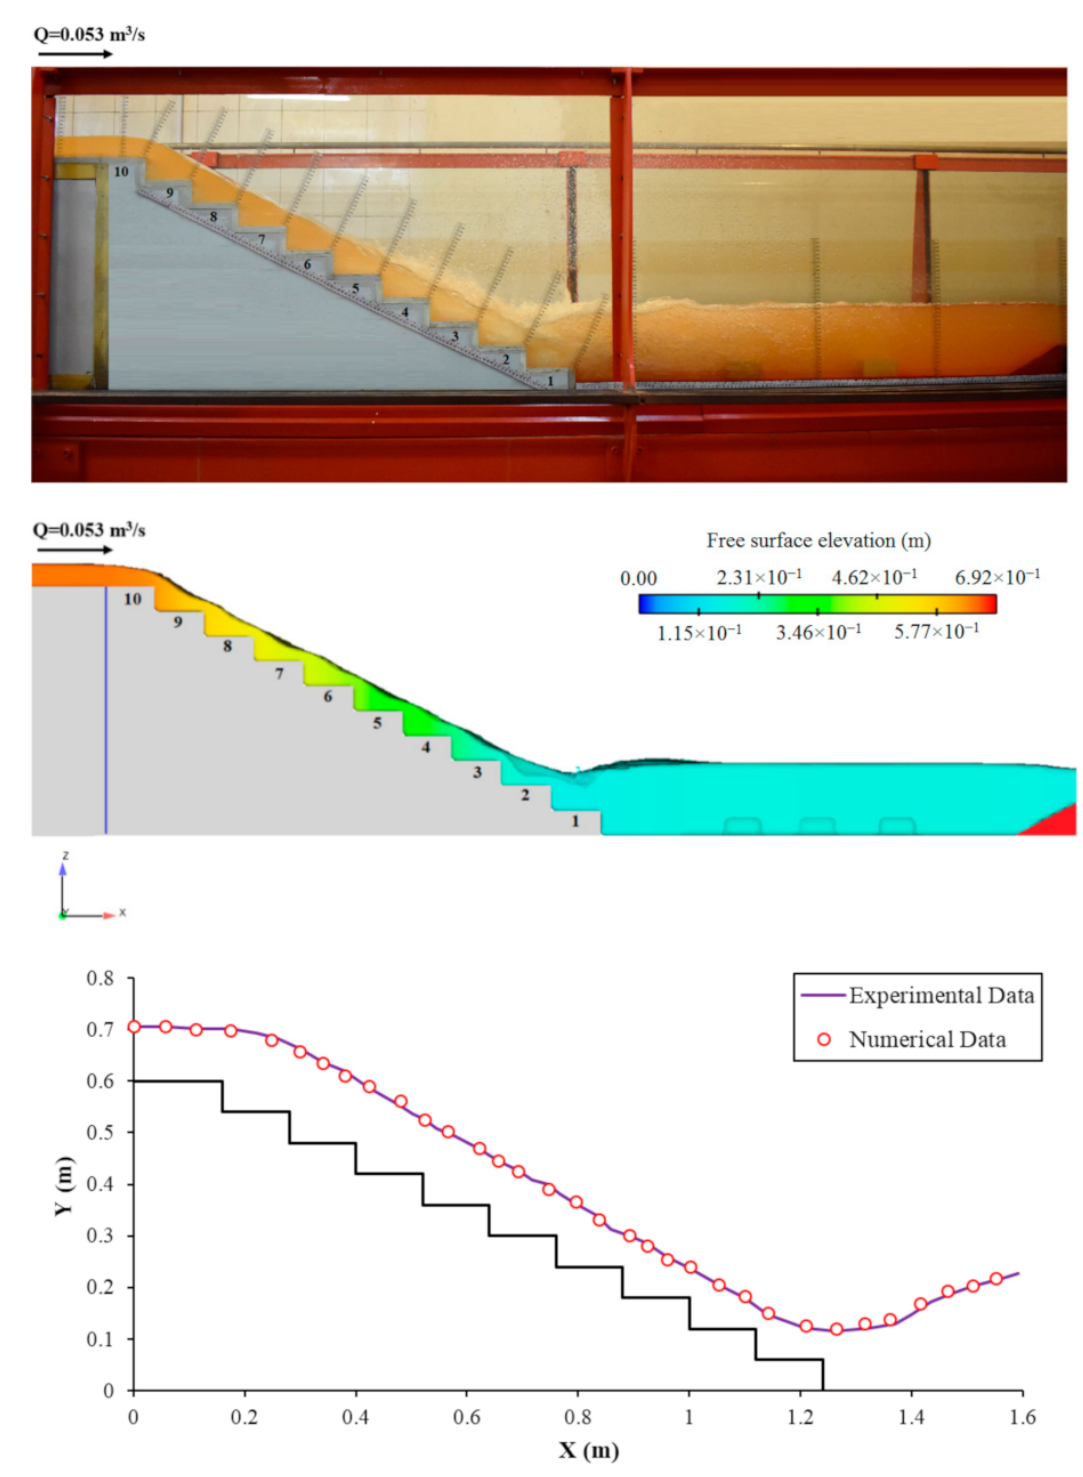
Figure 9. Comparison between the experimental and numerical results of the free surface ( Q = 0.052 m 3